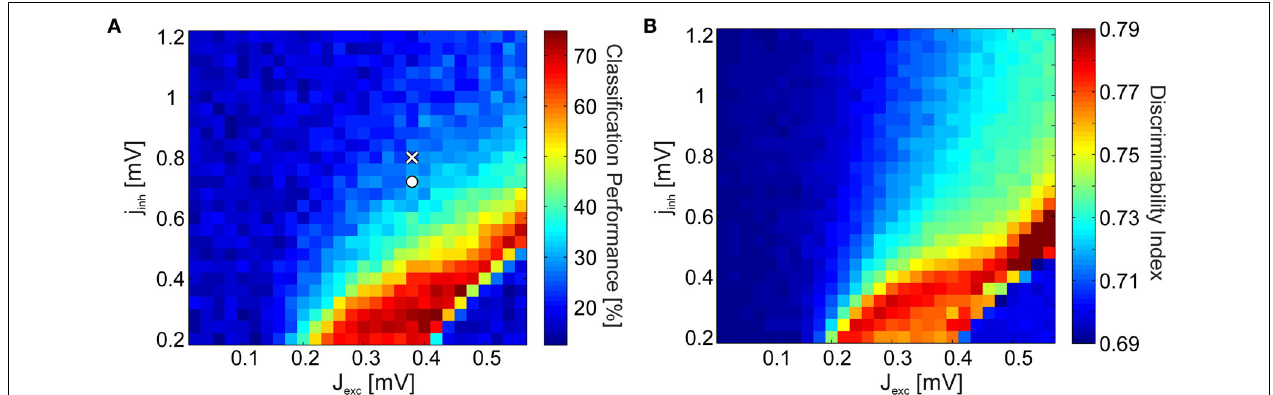
FIGURE 3 | SVM test results and the discriminability index. (A) SVM classification performance as a function of the excitatory coupling strength J exc and the inhibitory coupling scaling factor j inh (obeying J inh = (cid:4) · J exc · j inh ). The coupling values representing the non-attended and